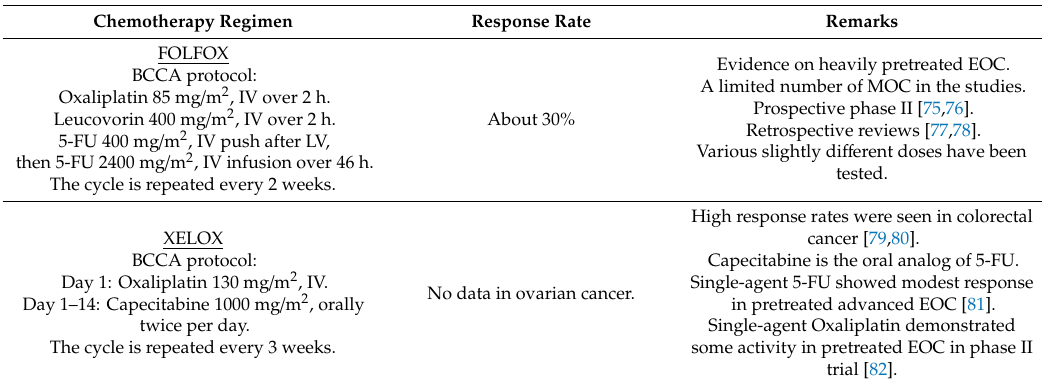
Table 3. Summary of the GI protocols used in